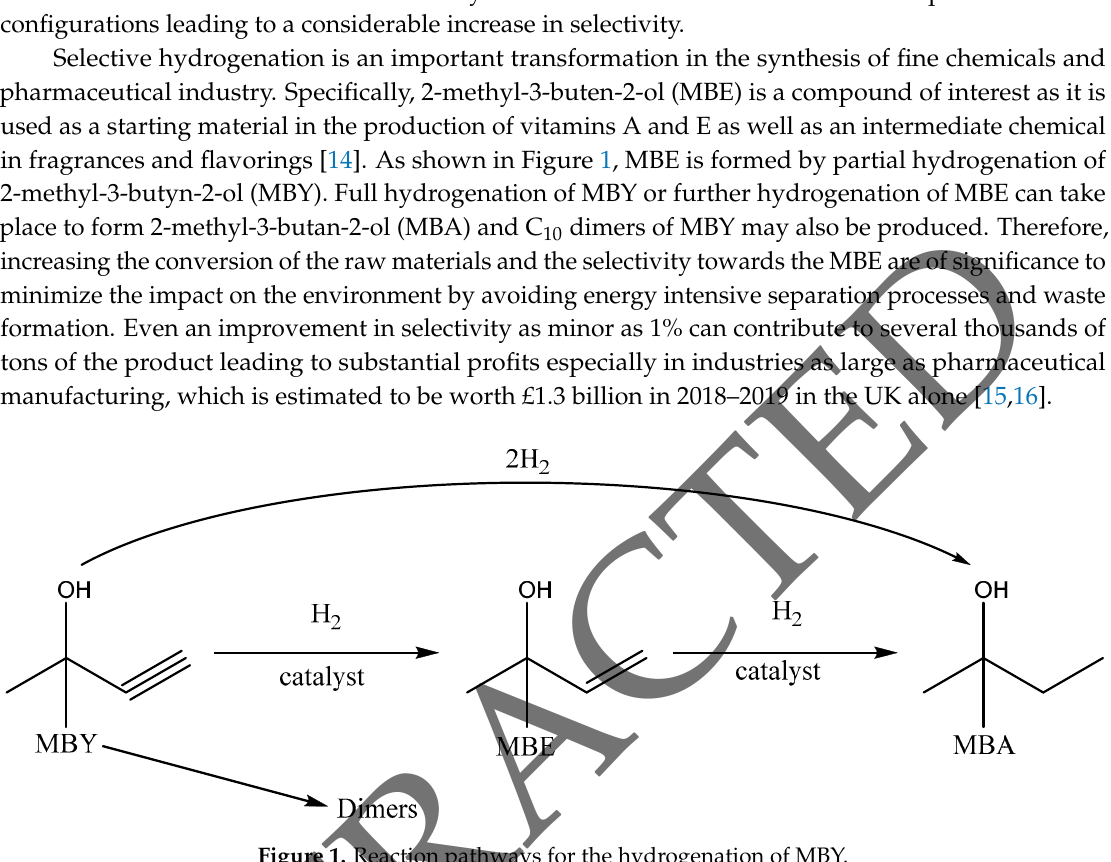
Figure 1. Reaction pathways for the hydrogenation of MBY.